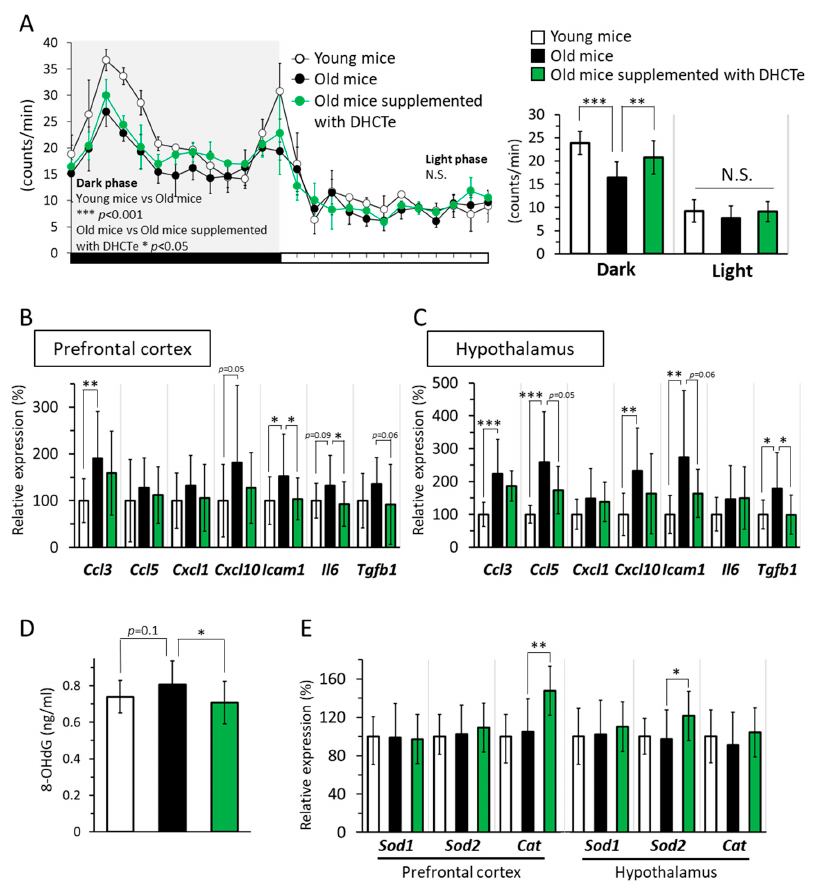
Figure 4. DHCte supplementation suppressed age-associated reduction of physical activity and inflammation and oxidative stress in the brain. ( A ) (Left) The time course of locomotive activity in young and old C57BL/6J mice fed either an ND or an ND supplemented with DHCte for 56 days. (Right) Locomotor activity of mice in young and old mice was measured during 12 h. ( B ) mRNA expression levels of C-C motif chemokine ligand 3 (Ccl3), C-C motif chemokine ligand 5 (Ccl5), C-X- C motif chemokine 1 (Cxcl1), C-X-C motif chemokine 10 (Cxcl10), intercellular adhesion molecule 1 (Icam1), interleukin 6 (Il6), and transforming growth factor- β 1 (Tgfb1) in the prefrontal cortex. ( C ) mRNA expression levels of Ccl3, Ccl5, Cxcl1, Cxcl10, Icam1, Il6, and Tgfb1 in the hypothalamus. ( D ) 8-hydroxy-2-deoxyguanosine (8-OHdG) in the brain. ( E ) the mRNA expression levels of superoxide dismutase-1 (Sod1), superoxide dismutase-2 (Sod2), and catalase (Cat) in the prefrontal cortex and hypothalamus of young and old C57BL/6J mice fed either an ND or an ND supplemented with DHCte for 84 days. The values represent the means ± standard deviation ( n = 14–22). * p < 0.05; ** p < 0.01; *** p < 0.001.